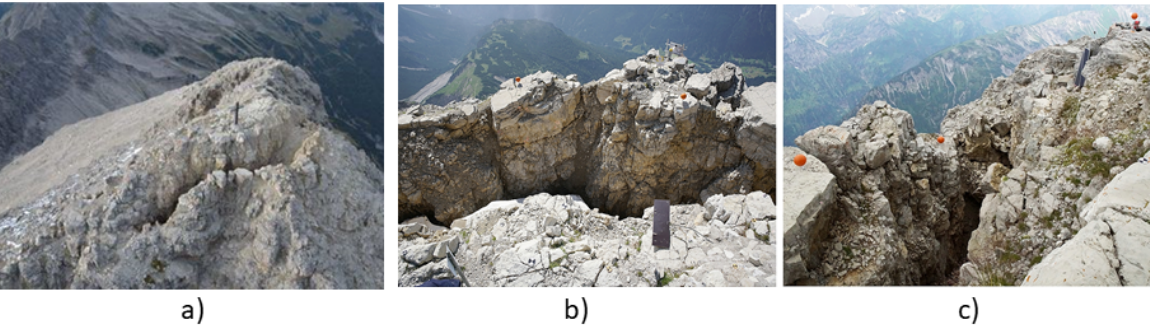
Figure 1. Overview of the Hochvogel mountain, a) The summit with prominent crevice, b) View of the crevice in SE direction (expected rock fall direction), c) View of the crevice in SW